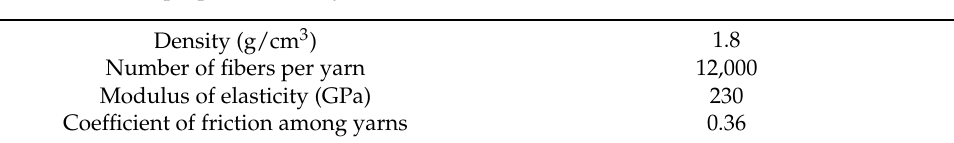
Table 2. Material properties of the